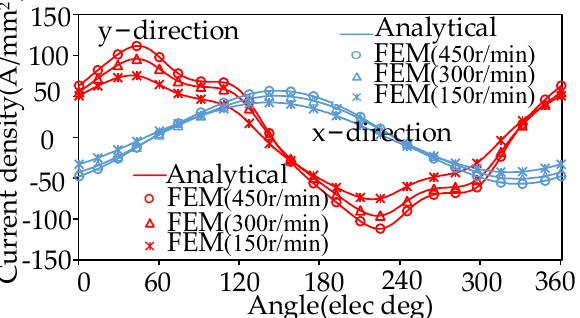
Figure 7. Eddy-current density distributions along the x-direction in the middle of the copper.